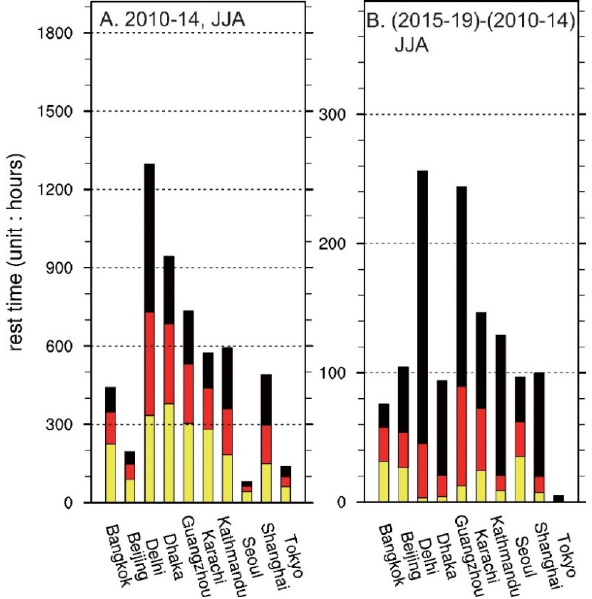
Figure 3. ( A ) Accumulated JJA rest hours during 2010–2014 for the selected Asian cities. Yellow, red, and black colors correspond to rest time due to the particular flag condition; ( B ) same as in ( A ) but showing the difference between the periods of 2015–2019 and 2010–2014 (former minus the lat-